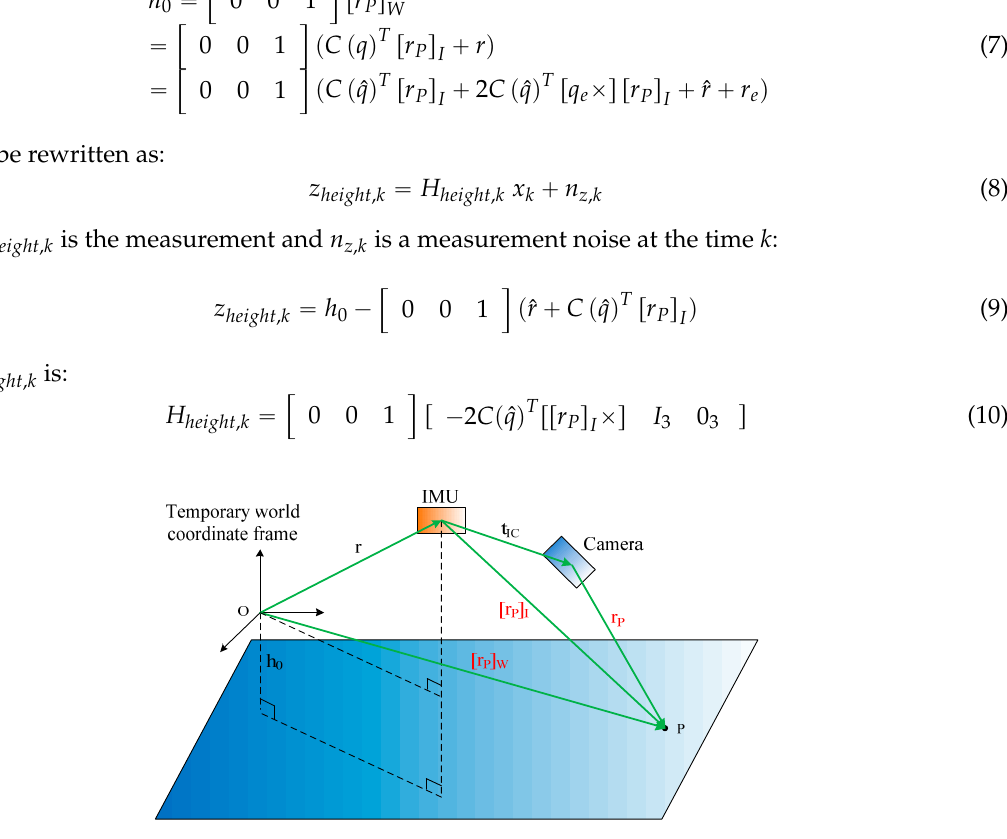
Figure 4. Position updating from laser point coordinates.